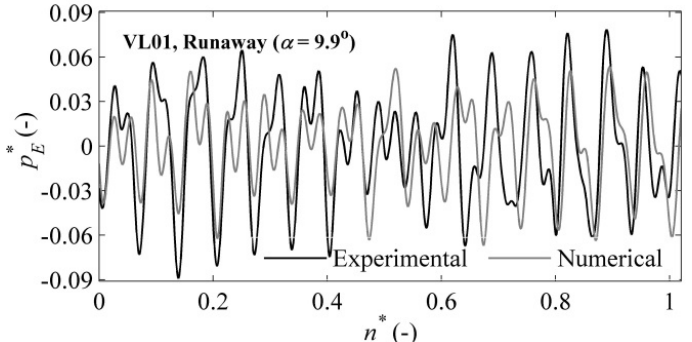
Figure 9. Instantaneous pressure fluctuations in the vaneless space (VL01) over a complete rotation of the runner at the runaway point α = 9.9 ˝ ; fluctuations occur at a rotor stator interaction and blade passing frequency of 262.2 Hz and its harmonic of 131.1 Hz.